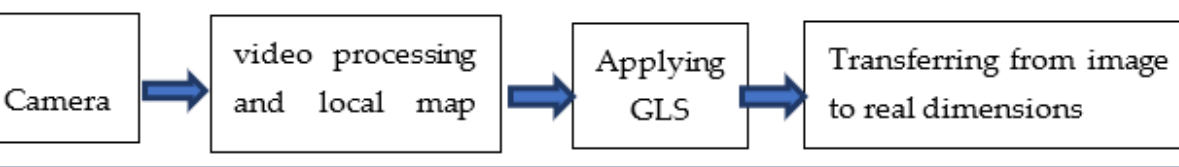
Figure 7. Processes of determining the position of the robot.